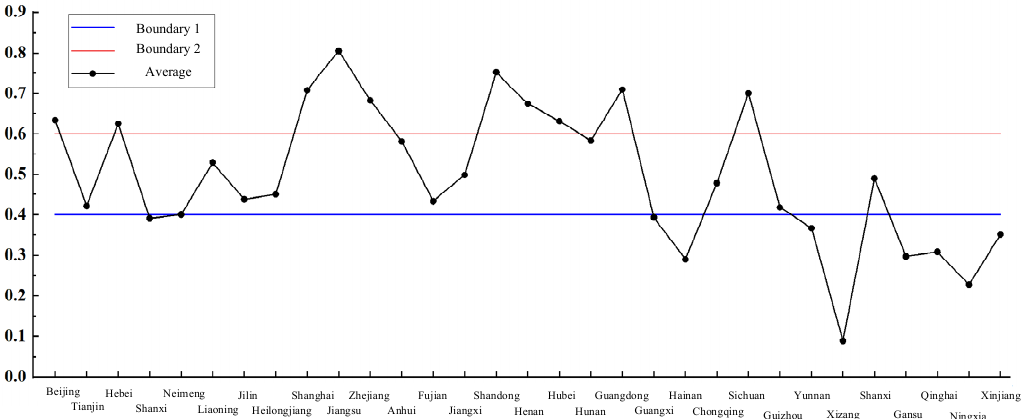
Figure 8. The mean degree of supply and demand coupling among various regions from 2020 to 2024.